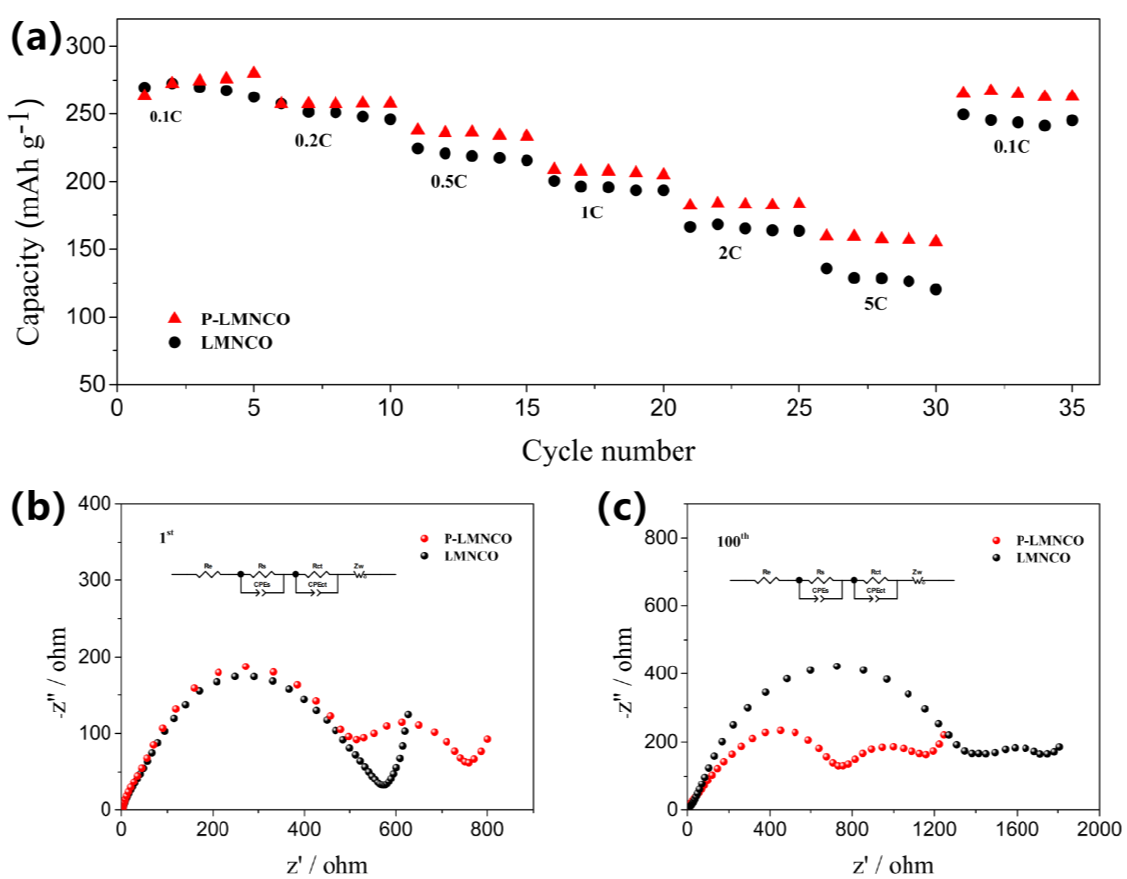
Figure 7. ( a ) Rate capacities of LMNCO and P-LMNCO. Nyquist plots of LMNCO ( b ) and P-LMNCO ( c ) samples.